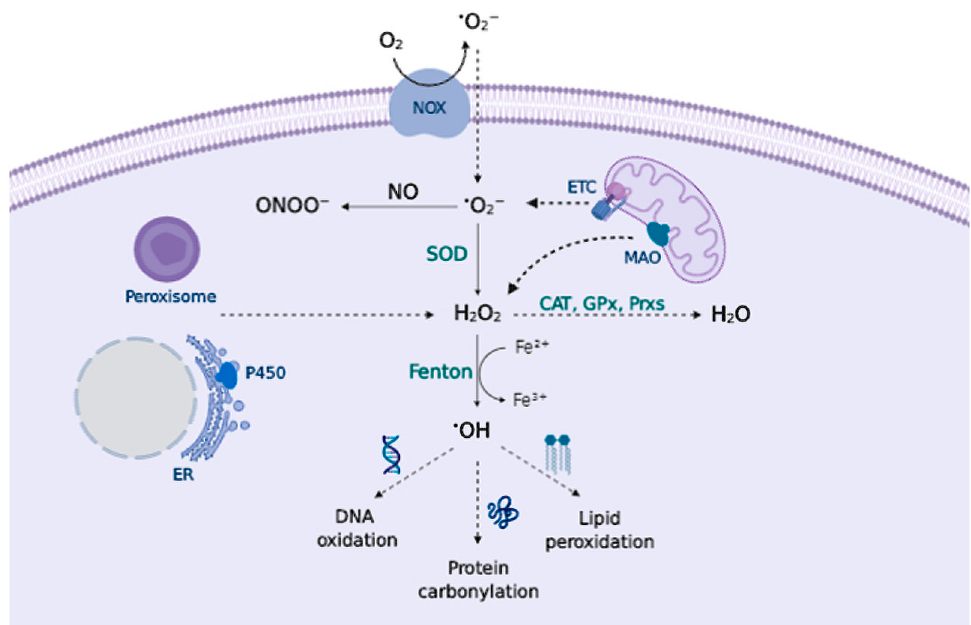
Figure 1. Principal RS sources and sinks. Transmembrane NADPH oxidases (NOX) and the mitochondrial ETC generate ˙ O 2 ¯ that can be converted to ONOO − in presence of NO, or can be converted to H 2 O 2 by superoxide dismutase (SOD). Peroxisomes, endoplasmic reticulum (ER), and mitochondrial monoamine oxidase (MAO) also contribute to H 2 O 2 production. Catalase (CAT), glutathione peroxidase (GPx), and peroxiredoxin (Prx) remove H 2 O 2 ; otherwise, metal-catalyzed Fenton reactions generate ˙ OH that oxidizes cellular biomolecules.